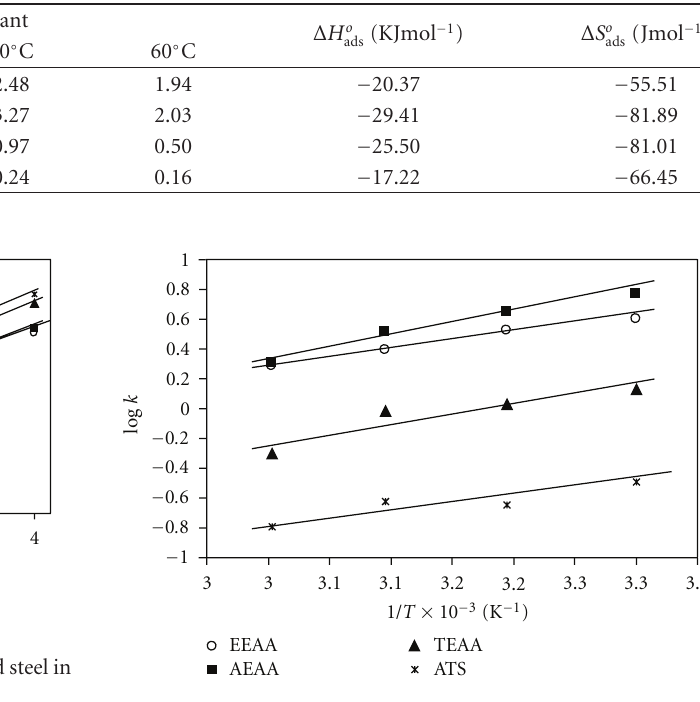
Figure 7: Curve fitting of log K data against